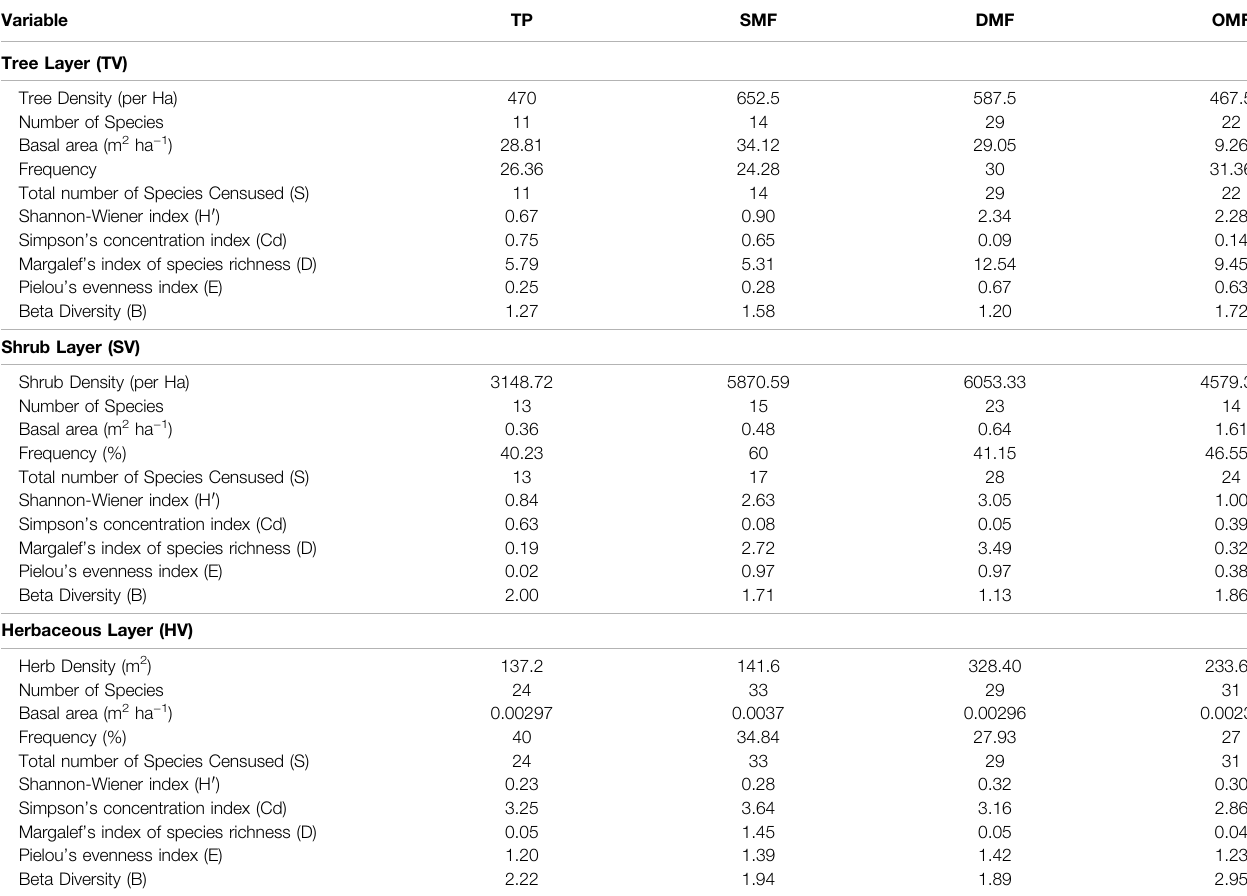
TABLE 2 | Species diversity indices in dry tropical forest of AABR. Variable Tree Layer (TV) Tree Density (per